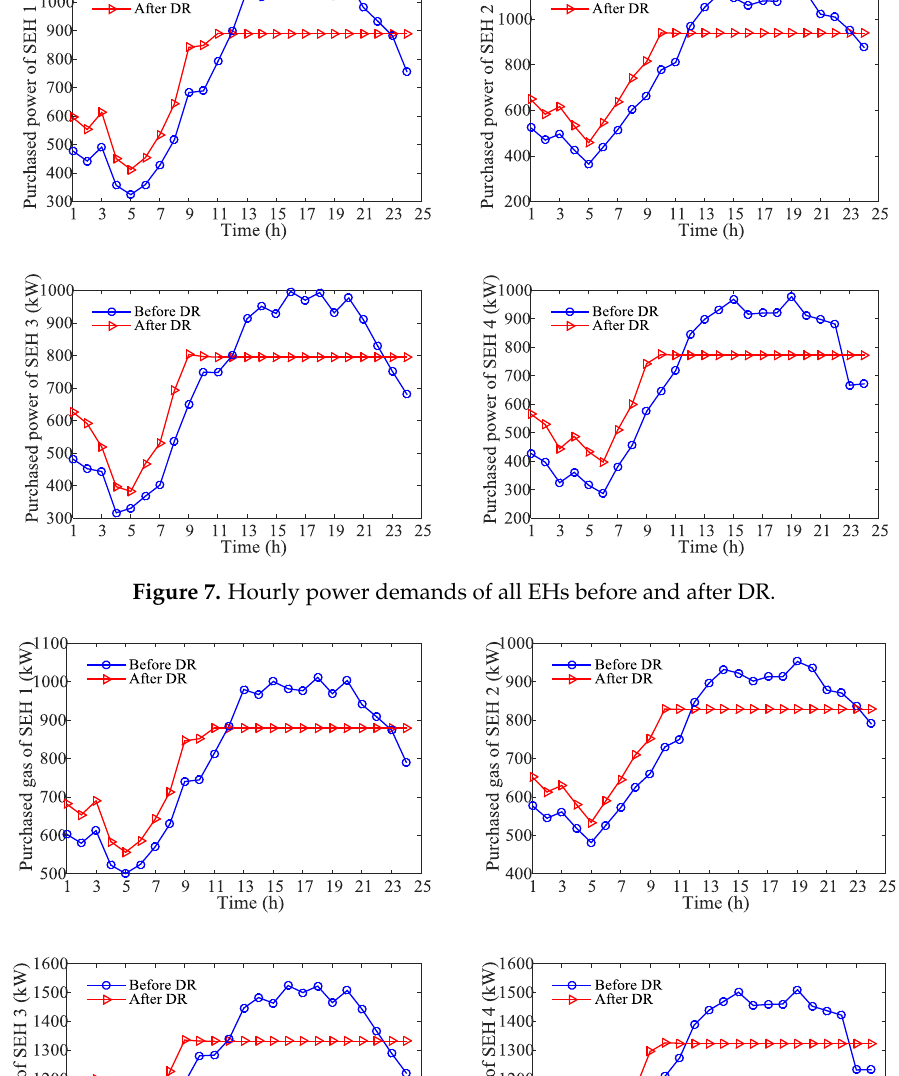
Figure 6. Real time energy supply by the energy provider (EP) before and after DR.